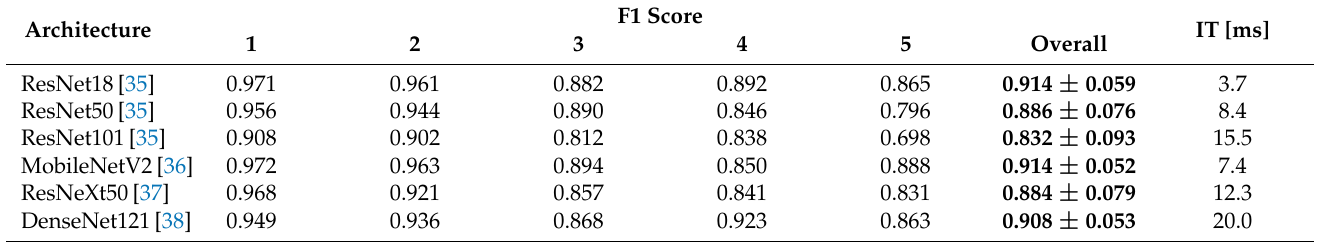
Table 4. Comparison of different state-of-the-art networks for image classification. The F1 score is given as a mean result of all runs of the day-wise five-fold cross-validation including the overall standard deviation. Inference time (IT) was evaluated on a single batch of size 8 on a Nvidia GeForce RTX 2060 .